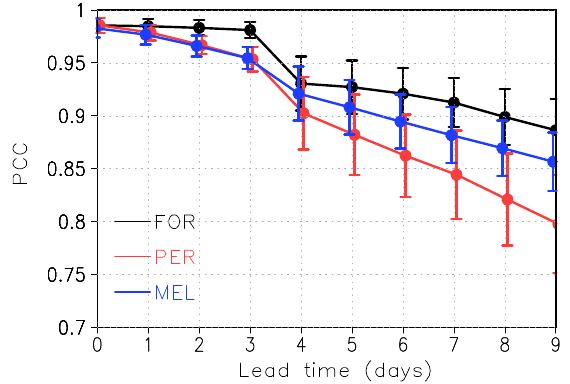
Figure 10. The PCCs between forecast and analysis SIT from the full physics model (black), persistency (red) and a simple melting model (blue) in early summer (June–July) averaged from 2014 to 2016. Error bar indicates the standard deviation of the